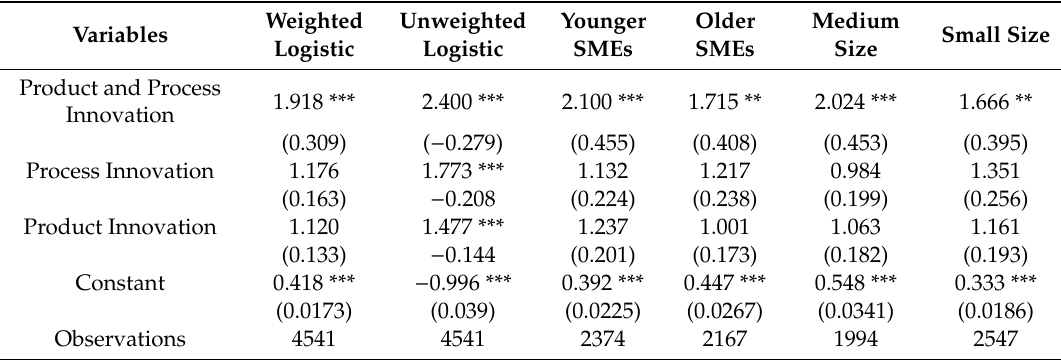
Table 4. Logistic regression coe ffi